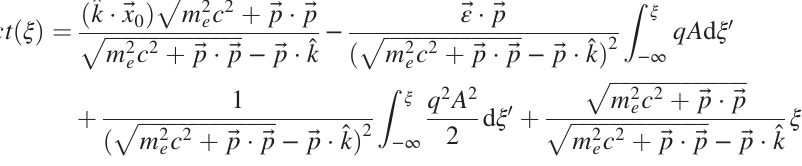
p ffiffiffiffiffiffiffiffiffiffiffiffiffiffiffiffiffiffiffiffiffiffiffiffiffiffi c 2 þ ⃗ p · ⃗ p m 2 e